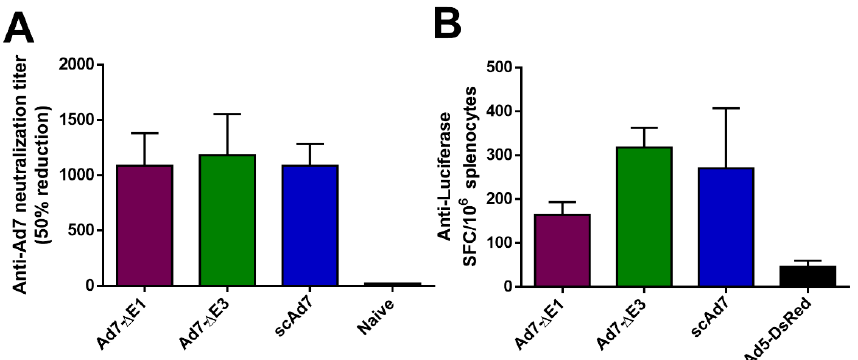
Figure 5. In vivo Ad7 neutralization and Anti-Luciferase cellular immune response in hDSG transgenic mice. Human desmoglein (hDSG) transgenic mice ( n = 5) were vaccinated via the i.m. route with 10 10 vp per mouse of the indicated virus. The anti-Ad7 antibody response was determine by a neutralization assay with 50% reduction of luciferase expression ( A ). The cellular immune response against the luciferase reporter was examined with an ELISPOT ( B ). Mice were immunized with a replication-deficient Ad5 vector expressing only DsRed as a negative control in this luciferase ELISPOT. Data are expressed as the mean with standard error (SEM).